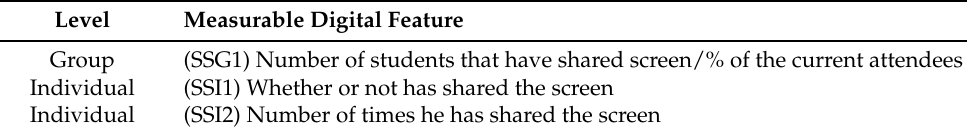
Table 11. Set of digital features defined for “Screen sharing” category, corresponding to the feature